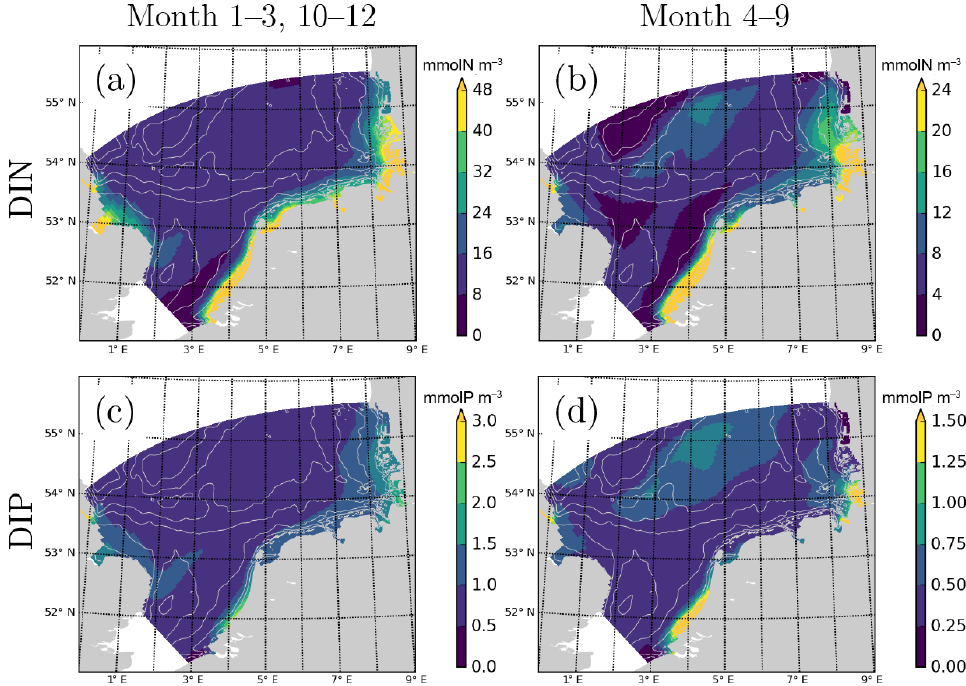
Figure 11. DIN (a, b) and DIP (c, d) concentrations at the surface layer, averaged over the non-growing (months 1–3 and 10–12, left) and growing seasons (months 4–9, right) for the entire simulation period (2000–2010). Concentrations at the bottom layer are almost identical for months 1–3 and 10–12 and similar for months 4–9. Gray lines show the isobaths. Note the different color scales used for each panel and that the scale used for DIN is 16 times that of DIP, such that the identical coloring for DIN and DIP for the same season indicates a Redfield ratio of 16 :